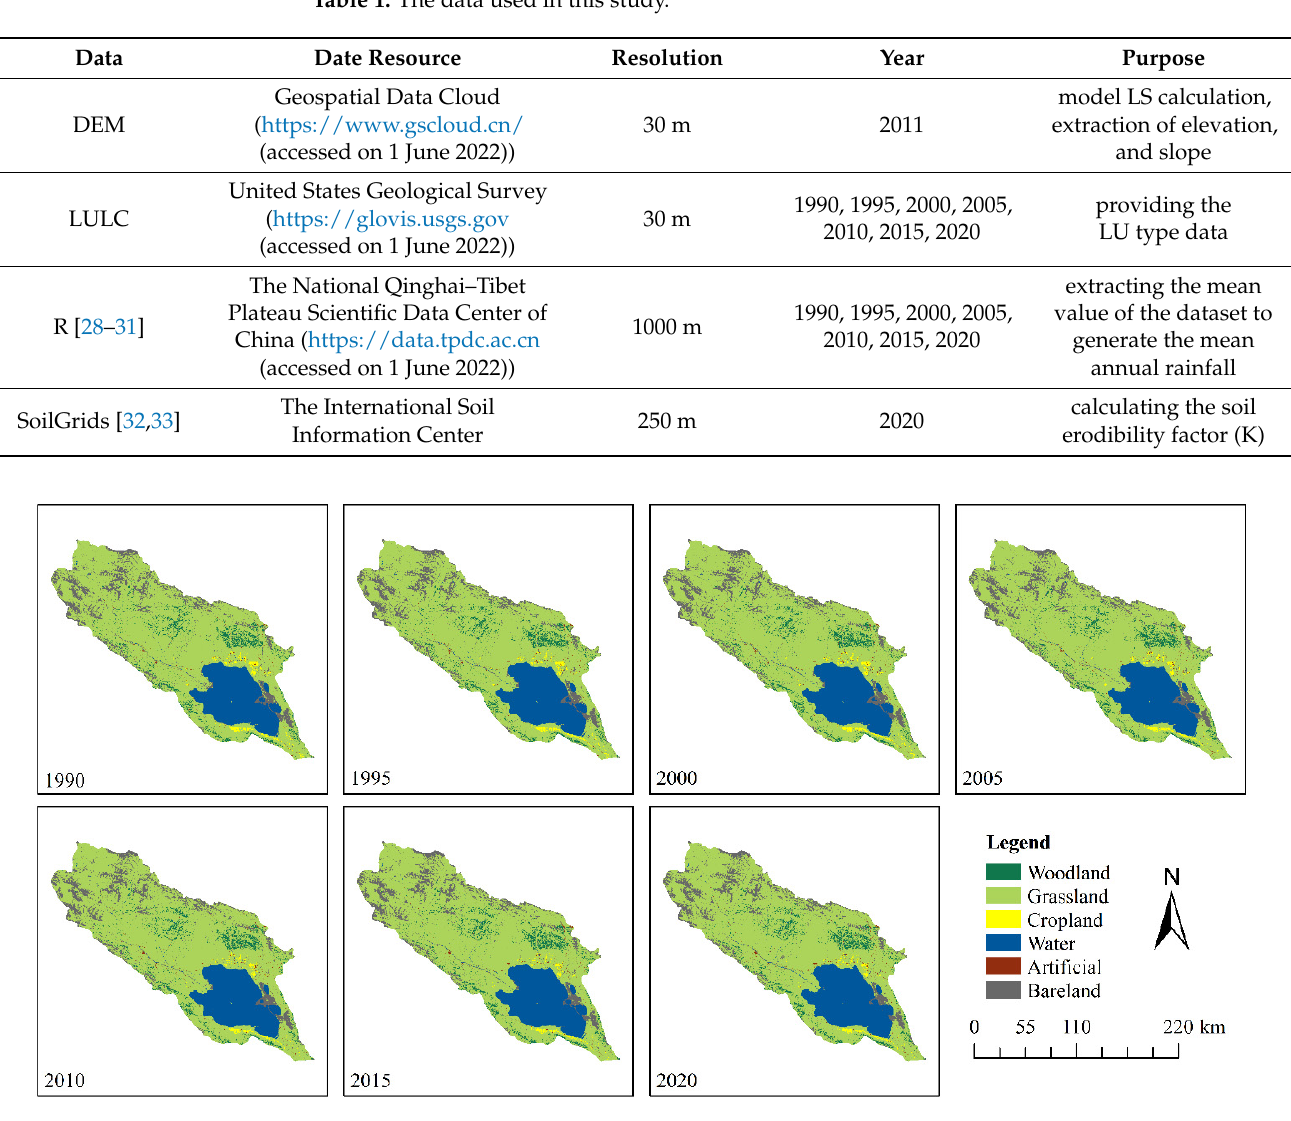
Table 1. The data used in this study.